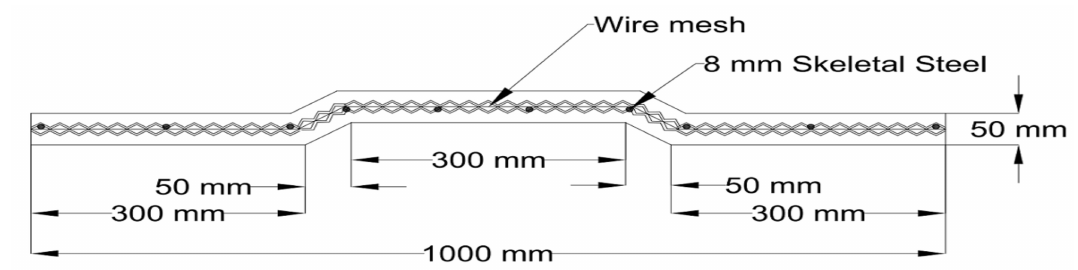
Figure 3. Cross Section view of Panel with four layers of chicken mesh.